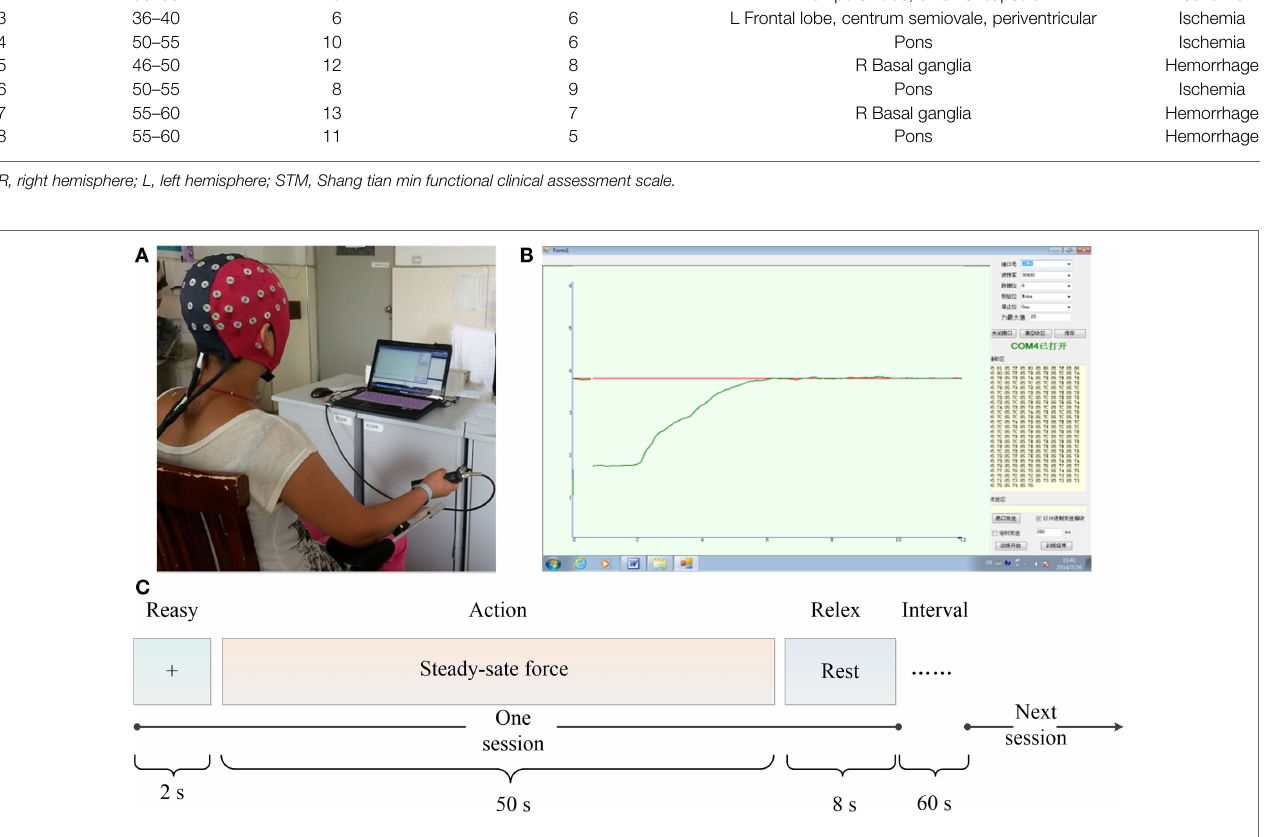
FIGURE 1 | Experimental setup. (A) Recording of electroencephalogram and electromyogram data. (B) Force profile generated by the mainpulandum during 1 trial: the red line indicated the target force and the green line represented the exerted force. (C) The flow of the experimental